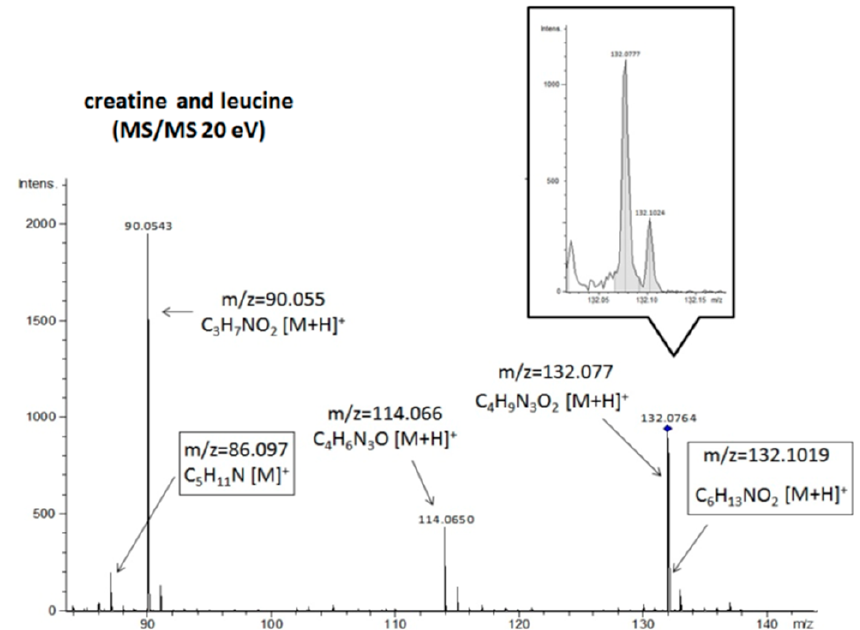
Figure 3. The results of MS/MS fragmentation of selected metabolites ( m / z —132,0777 and m / z — 132,1024). MS/MS spectra obtained in positive ionization mode. Collision energy—20 eV. Reference m / z value of fragments of leucine, creatine, chemical formula and ion type (taken from the public metabolite database) are also indicated in the figure.